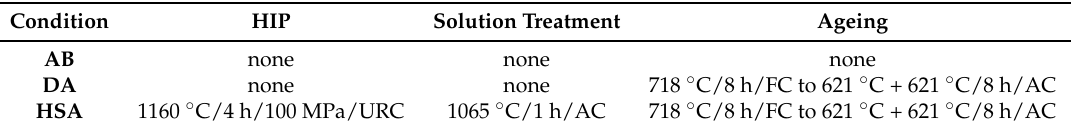
Table 2. Post-treatment conditions.